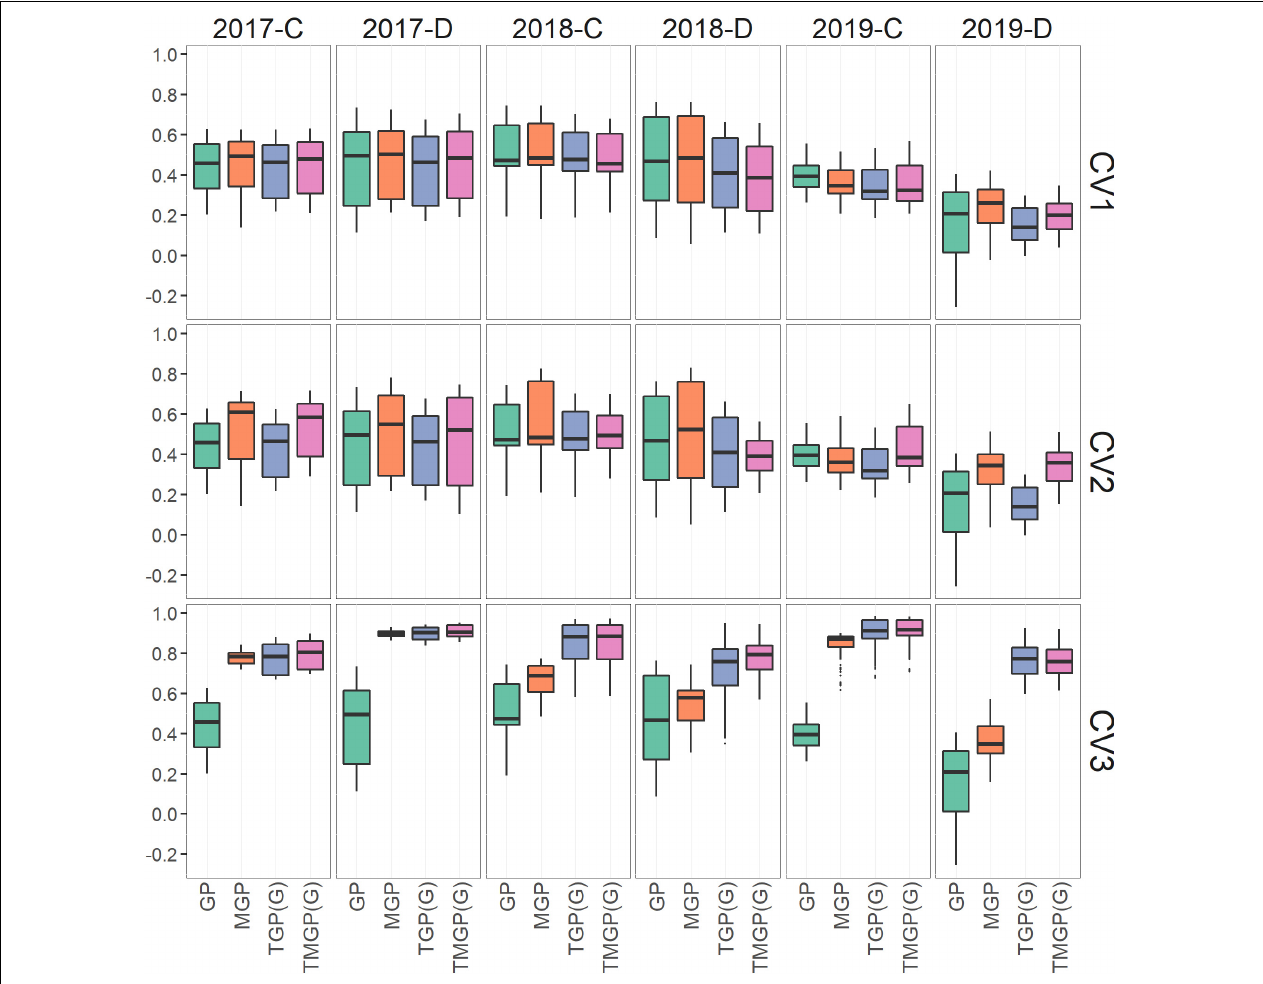
FIGURE 7 | Comparison of accuracy of the prediction models. The correlation coefficients between genotypic values and their predicted values are plotted. The results of CV1, CV2, and CV3 are shown in three